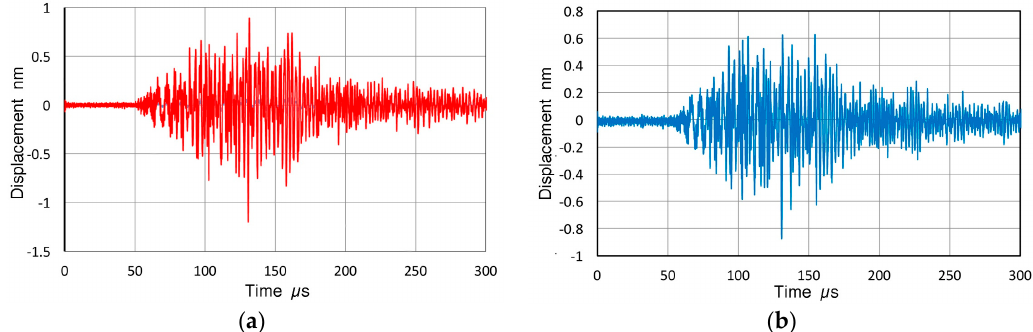
Figure 2. ( a ) Normal displacement in nm vs. time measured at L = 300 mm at the center of the test bar; ( b ) Normal displacement in nm vs. time measured at L = 300 mm at 5 mm off-center.